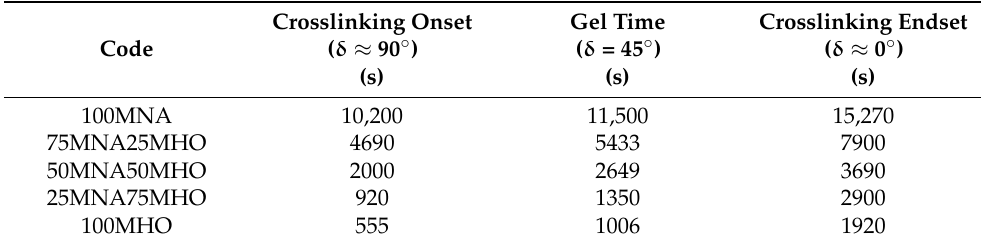
Table 4. Most relevant data obtained from the rheometer on the curing process of epoxidized hemp oil (EHO) crosslinked with methyl nadic anhydride (MNA) and maleinized linseed oil